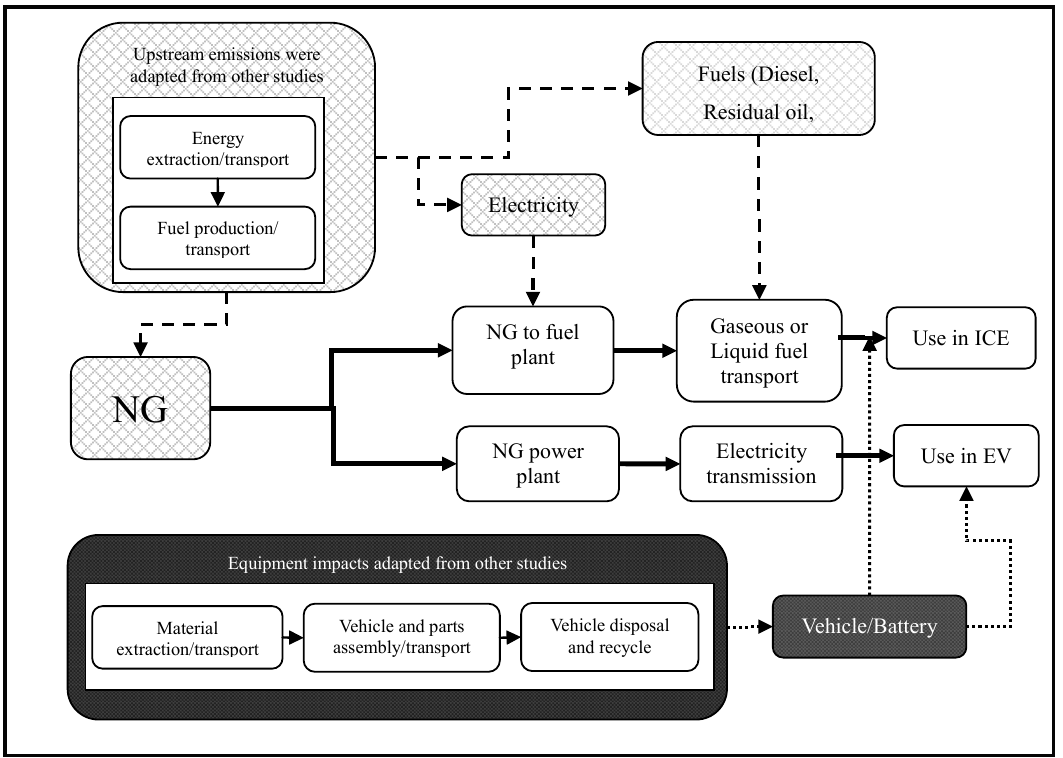
Figure 1. System boundary of included